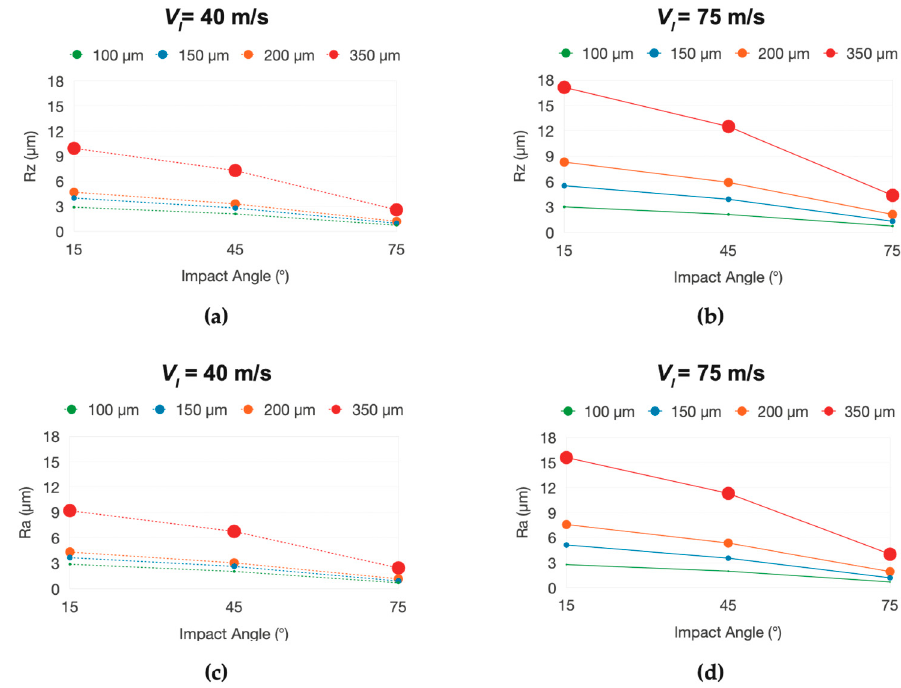
Figure 11. The FE surface roughness results at varied impact angles and impact velocities: ( a ) R z at V I = 40 m/s; ( b ) R z at V I = 75 m/s; ( c ) R a at V I = 40 m/s; ( d ) R a at V I = 75 m/s.